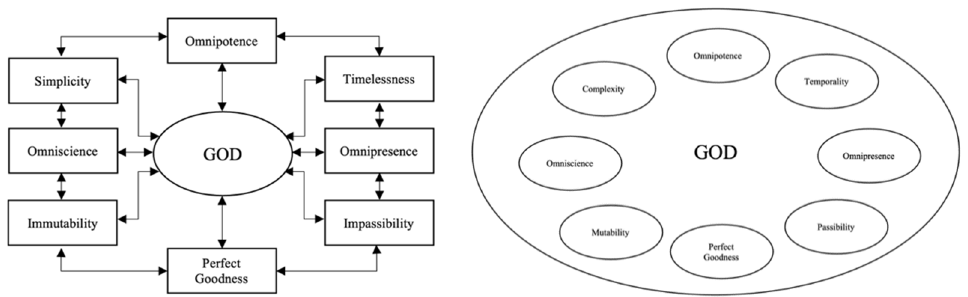
Figure 1. Classical and Neo-Classical Conceptions of God.